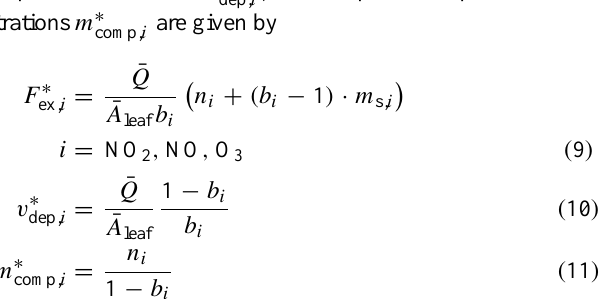
Figure 1. Schematic representation of the determination of bi-directional NO 2 exchange flux density ( F ex,NO2 ), NO 2 deposition velocity ( v dep,NO2 ), and NO 2 compensation point concentration ( m comp,NO2 ) from measurements of NO 2 concentrations at the plant chamber’s inlet ( m a,NO2 ) and outlet ( m s,NO2 ) under laboratory conditions ( m a,NO = m a,O3 = j ( NO 2 ) 0). (a) : by linear regression of m s,NO2 with m a,NO2 . (b) : by plotting F ex,NO2 vs. m s,NO2 . Dashed lines represent the limits of detection (3 σ -definition) for NO 2 concentration measurements (a and b panel) and the determination of the NO 2 exchange flux density (b panel), which are both defined by the sensitivity of the applied NO 2 analyzer (note: LOD ( m a,NO2 ) = LOD ( m s,NO2 )). Data points and error bars of NO 2 concentrations have been simulated to match R 2 ( m a,NO2 , m s,NO2 ) = 0.9925, error bars of NO 2 exchange flux have been calculated by Gaussian error propagation (c.f. Eq. (2)). Filled circles identify data points > LODs, hollow circles those ≤ LODs.